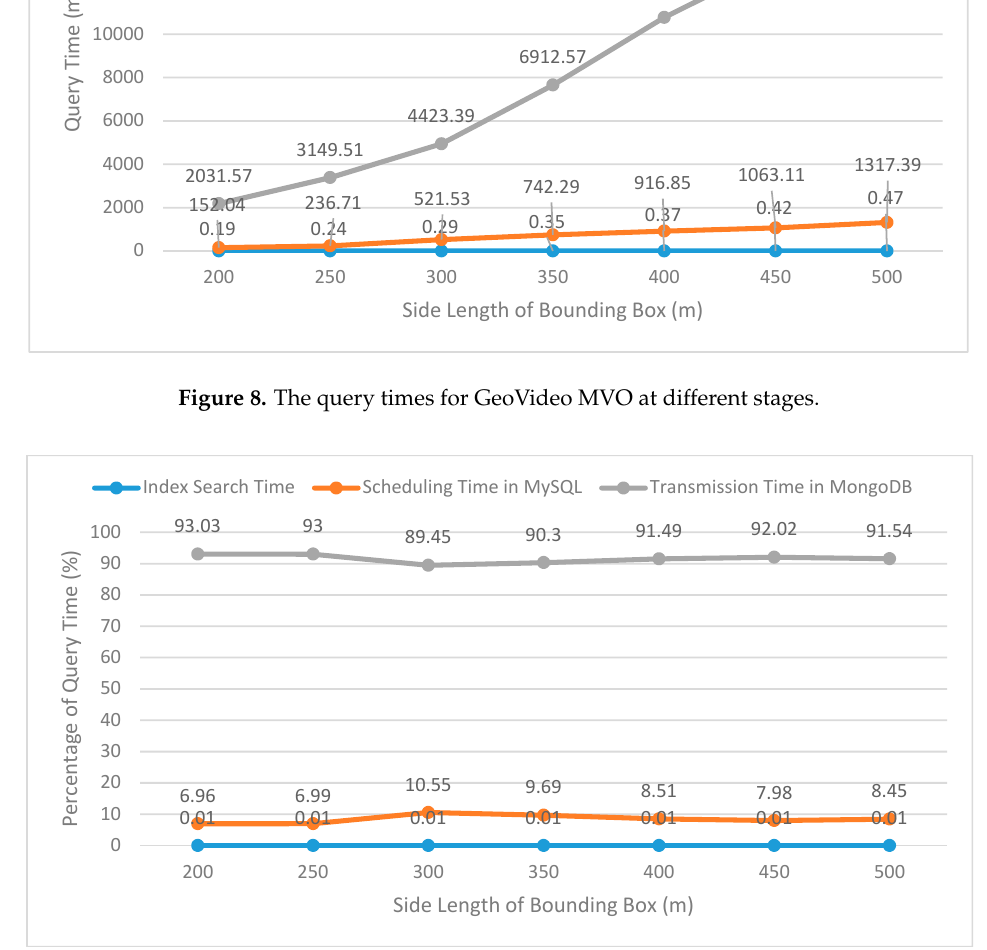
Figure 9. The query time percentages of the GeoVideo MVO at different stages.